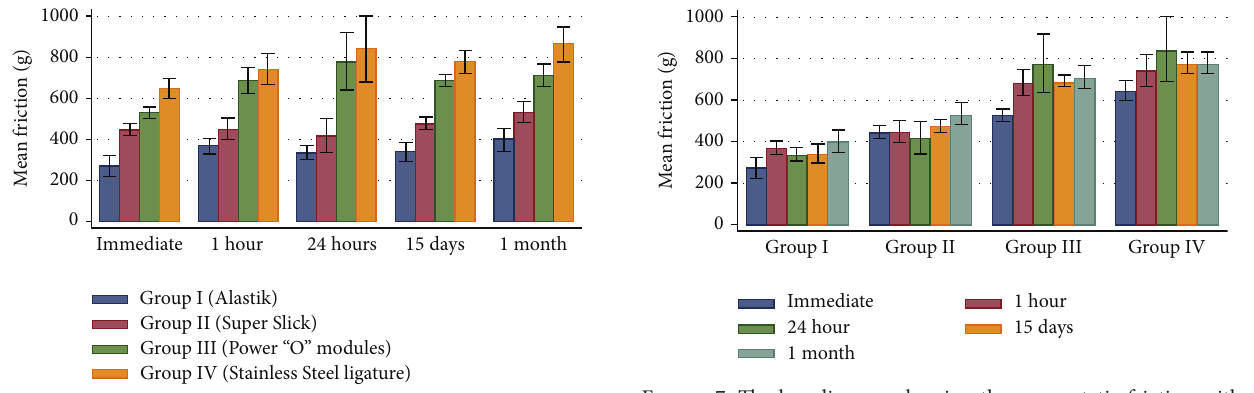
Figure 6: The bar diagram showing the mean static friction with standard deviations between the groups at different time periods (ANOVA test).